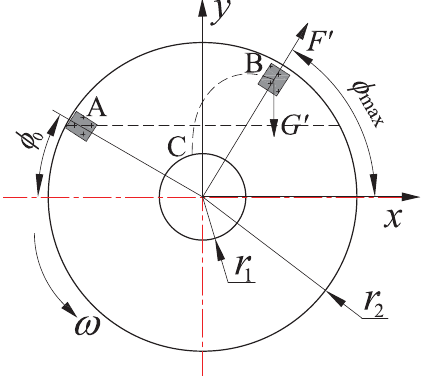
Figure 2. Shape of a concrete cross section at a certain time ( β = 12 ◦ , n = 3rmin − 1 ).